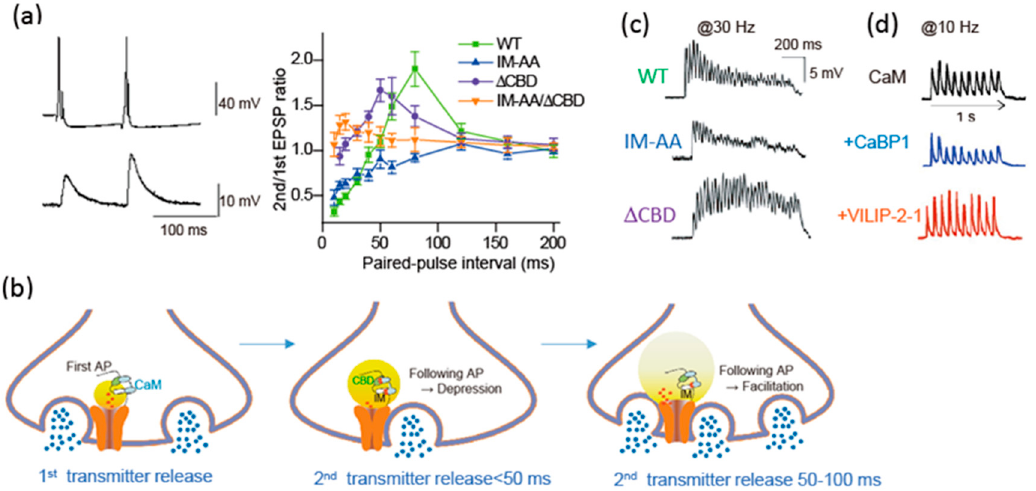
Figure 4. Temporal regulation of Ca 2+ channel activity by CaM and nCaS after AP(s) firing modulates synaptic transmission. (a) Regulation of transmitter release (lower trace) after an AP firing (upper trace). Dependent on the inter-stimulus interval the second AP induces paired-pulse depression (PPD) and facilitation (PPF). The PPD was prevented by Δ CBD, while PPF was prevented by IM-AA mutation of Ca V 2.1 channels. (b) Model for Ca 2+ /CaM-dependent inactivation and facilitation of Ca 2+ channels and neurotransmitter release. (c) Biphasic synaptic transmission during 1-s train of APs at 30 Hz changed to synaptic depression by the IM-AA mutation or to synaptic facilitation by the Δ CBD. (d) Overexpression of CaBP1 (blue) blocks synaptic facilitation, while overexpression of VILIP-2 (red)